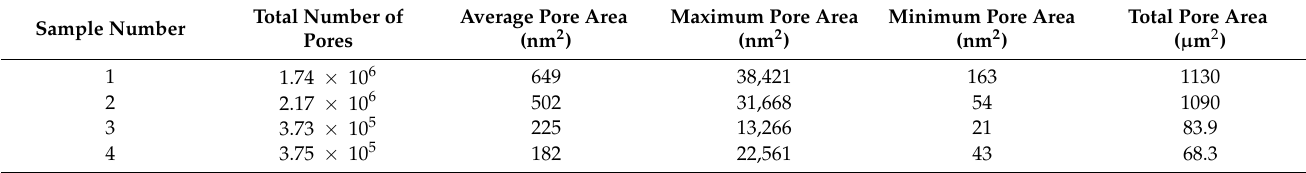
Table 1. Observation and analysis results of nanopore in C-S-H (the analysis area is 50,000 µ m 2 ).